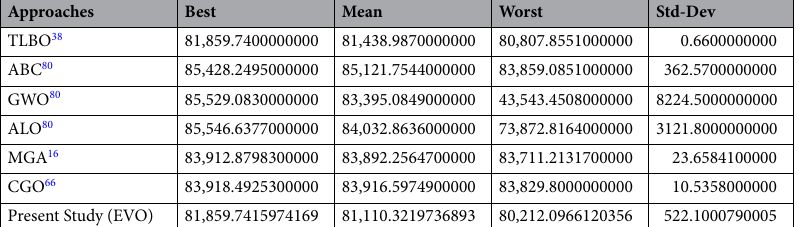
Table 15. Statistical results of different approaches for the rolling element bearing design problem.